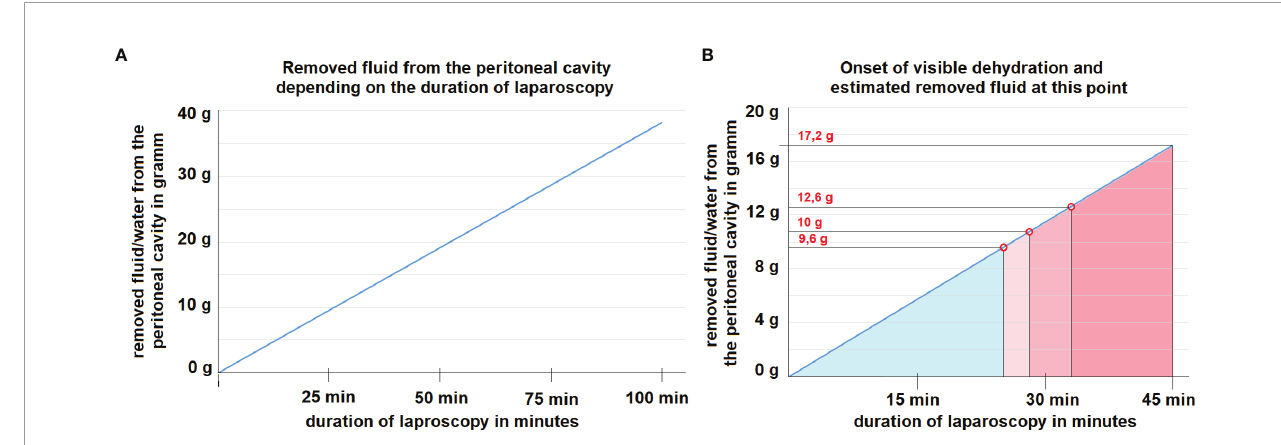
FIGURE 3 | (A) Mathematical model for the removal of fl uid/water from the abdominal cavity at 15 liter/minute fl ow rate assuming an in fl ow air humidity of 50%. The correlation is linear. (B) Mathematical model of dehydration at 15 liter/minute fl ow rate assuming an in fl ow air humidity of 50%. At the marked red points, dehydration of tissue is visible during laparoscopy. The estimated amount of removed water per time is indicated at each time